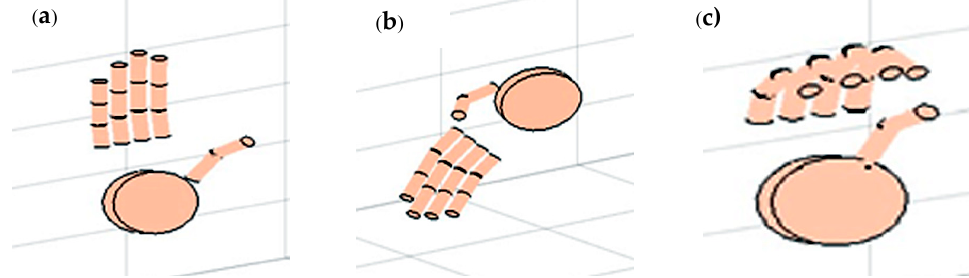
Figure 12. Different orientations of hand in front of LSSs: ( a ) hand held straight; ( b ) hand held upside down at an inclination; ( c ) fingers bend.